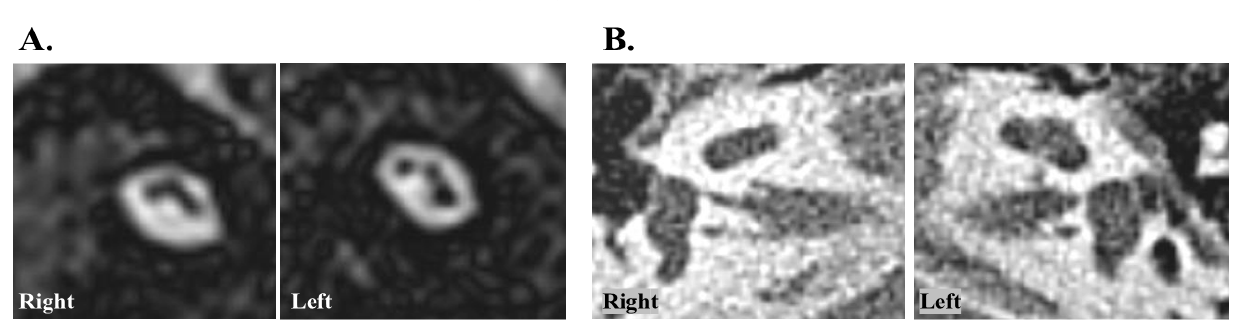
Figure 1. Representative imaging of cochlear nerve aplasia. ( A ) nonvisible cochlear nerve on oblique sagittal view of internal auditory canal magnetic resonance imaging. ( B ) absence of bony cochlear narrow canal on temporal bone computed tomography.